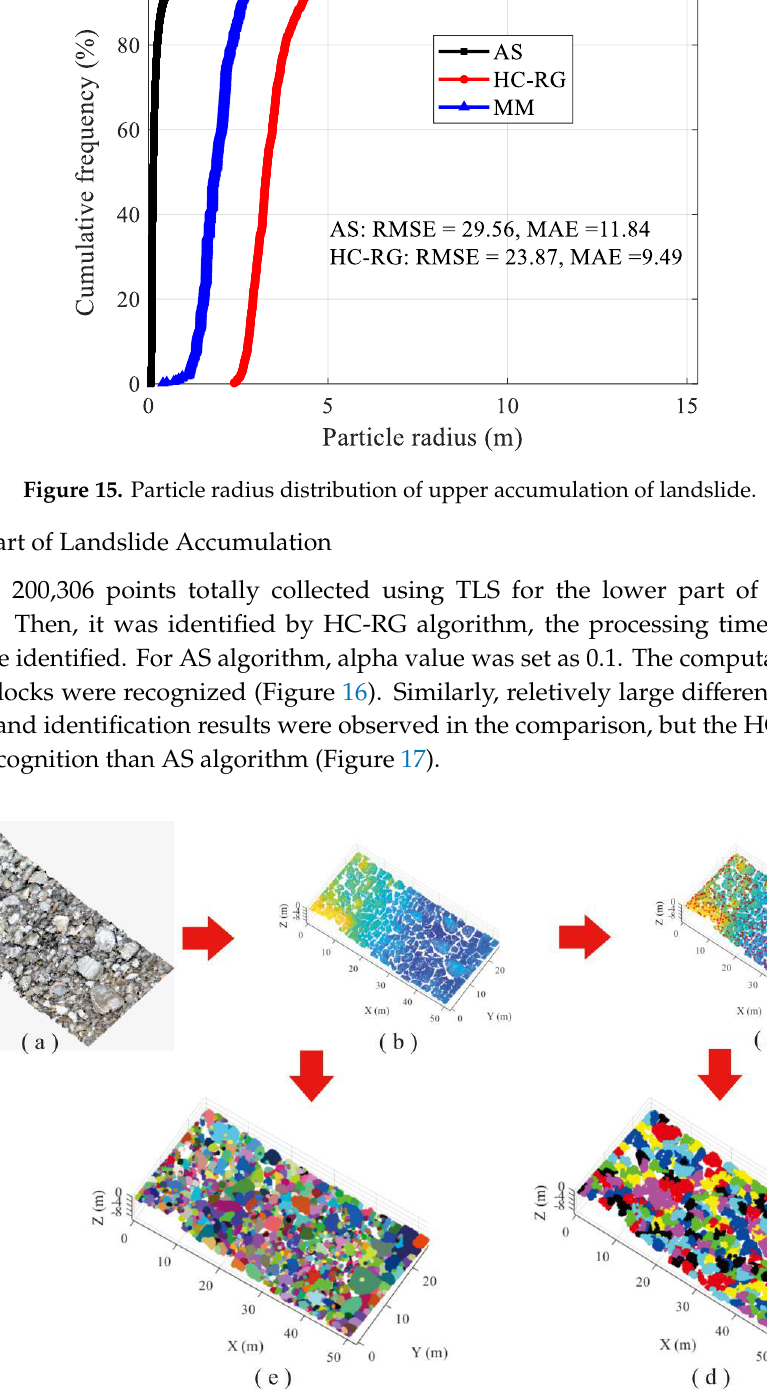
Figure 16. Comparison of recognition performance of lower part of landslide accumulation between two algorithms: ( a ) original point cloud with RGB color, ( b ) point cloud without color, ( c ) separation and peak point searching, ( d ) recognition using HC-RG algorithm, and ( e ) recognition using AS algorithm.